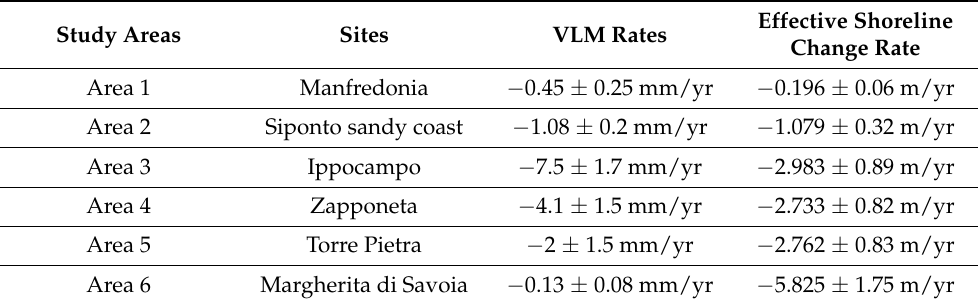
Table 3. Average VLM- and shoreline-change rates for the study areas. The assessment of effective shoreline-change rates is reported in Table S2—Supplementary Material.